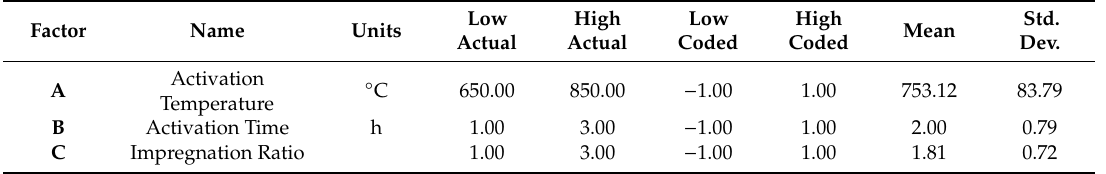
Table 1. Parameters Level of